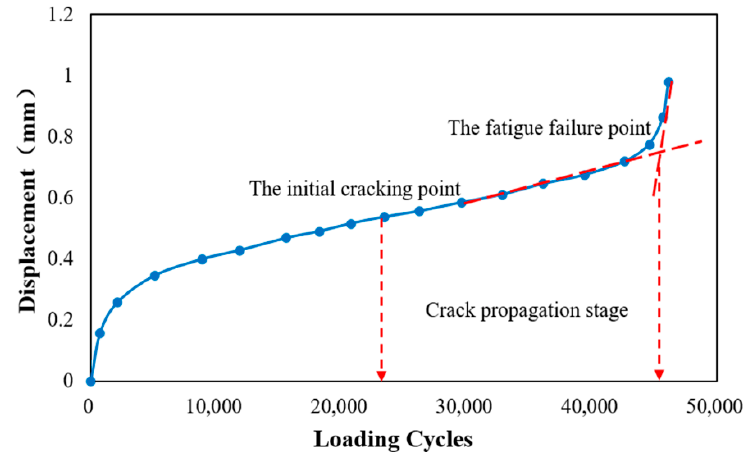
Figure 7. The position of the initial cracking point and fatigue failure point in the loading curve.